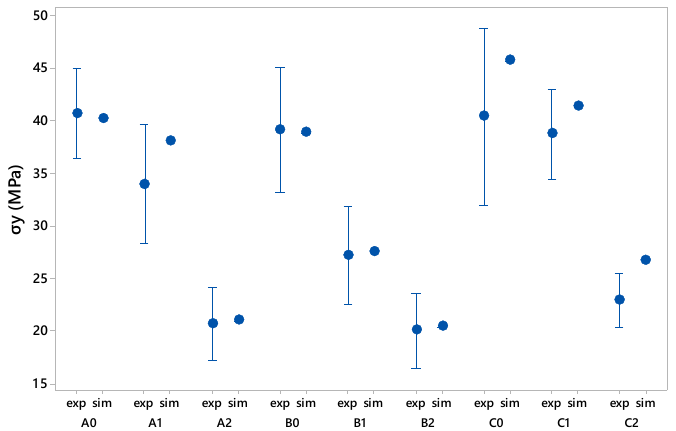
Figure 16. Comparative results of the experimental study (exp) and the simulation carried out (sim) for the yield stress.